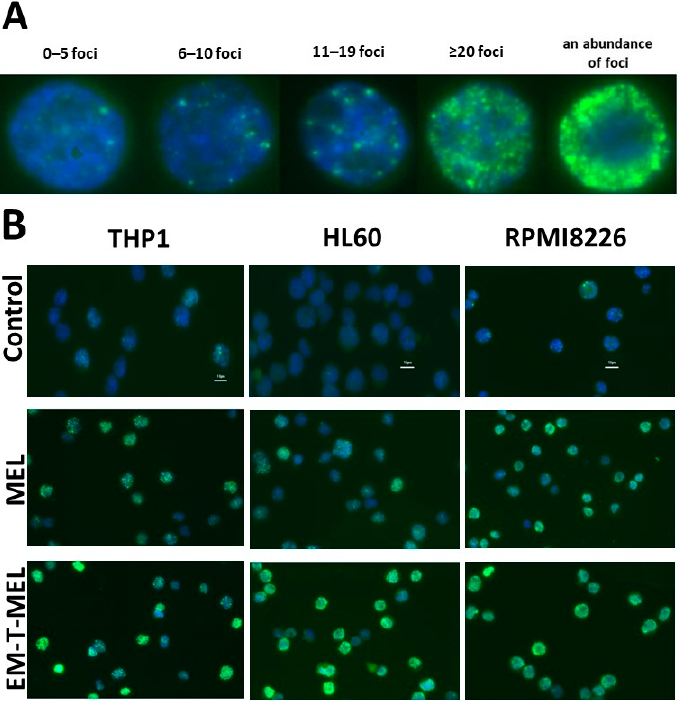
Figure 3. ( A ) Representative photos showing RPMI8226 cells with a number of foci (0–5; 6–10; 11–19; ≥ 20; an abundance of foci) per cell. ( B ) Detection and localization of γ H2AX histone foci in THP1, HL60, and RPMI8226 cells based on the highly specific antigen–antibody binding reaction. Sample images after 24 h of incubation. Cells were incubated with a phospho-(Ser139) mouse monoclonal IgG specific anti-H2AX antibody, and next with Alexa Fluor TM 488 goat anti-mouse IgG secondary antibody as described in the Materials and Methods section. The cell nuclei were stained with 4 ′ ,6-diamidino-2-phenylindole (DAPI) solution. The cells were visualized under a fluorescence micro- scope. Magnification: 400x, scale bar: 10 µm.